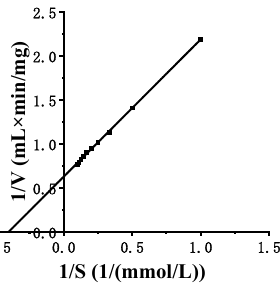
Figure 4. Effect of a substrate ( p -nitrophenyl α -D-galactopyranoside) on the rate of hydrolysis of α -galactosidase. Table 2. Hydrolysis of substrates by α -galactosidase.